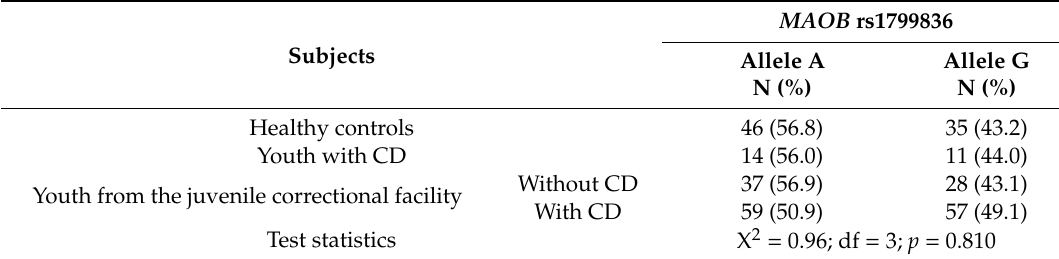
Table 2. MAOB rs1799836 allele frequency in male medication-naive youths who were subdivided into healthy controls, young patients with conduct disorder (CD), and youths from a juvenile correctional facility without CD and with CD.